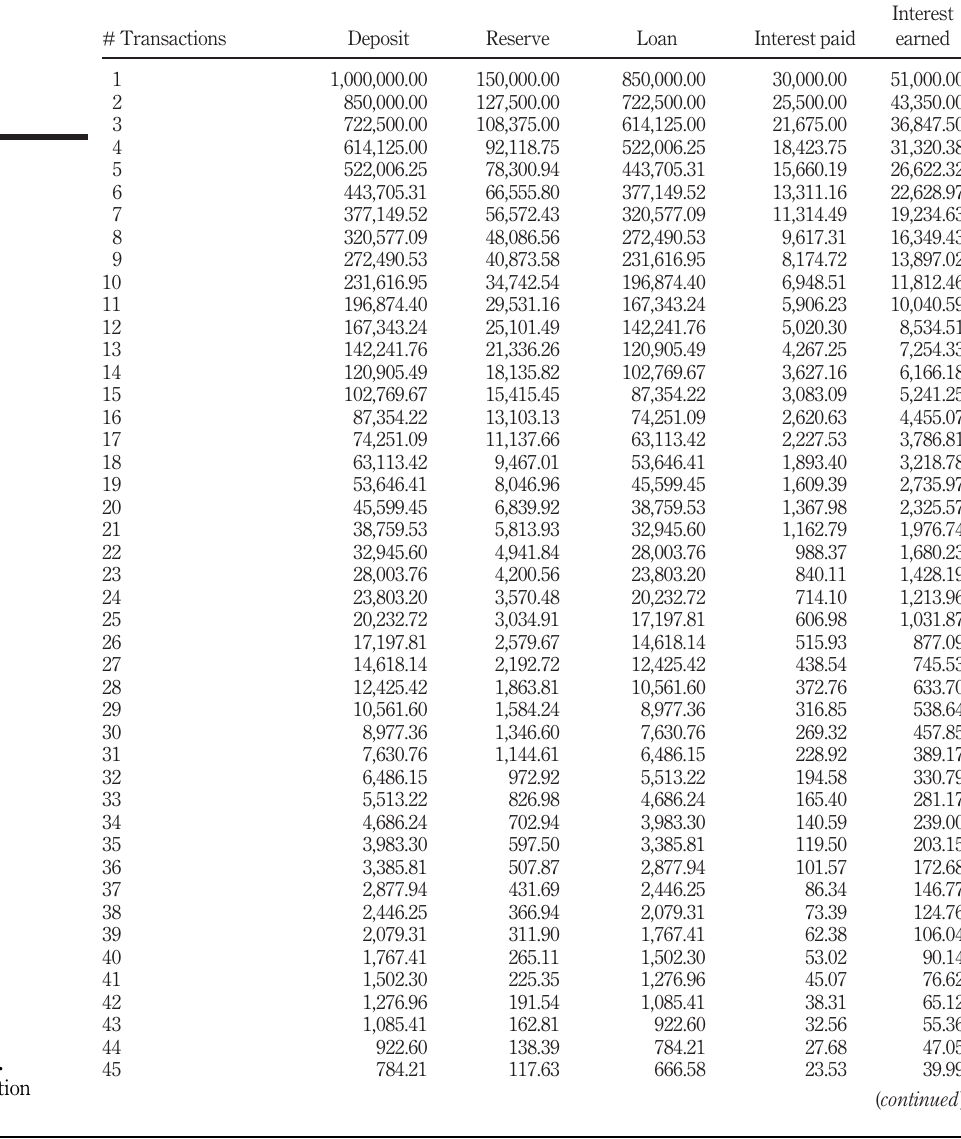
Table A1. Credit creation